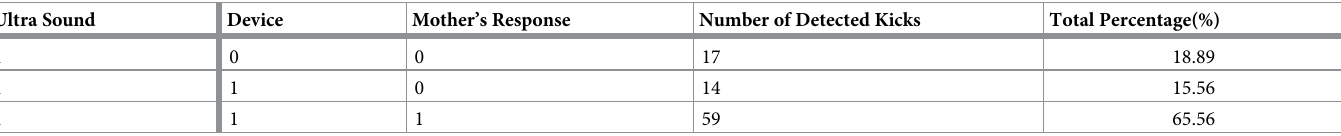
During the second phase of clinical testing three methods were utilized to identify the occurrence of a fetal movement. They are: the abdominal ultrasound, the in-house fabricated device and mother’s response. In the table ‘1’ indicates that the relevant method was able to identify the fetal movement and ‘0’ indicates that the method was not able to identify the fetal movement. For instance the first data row of the table indicated the number of realizations captured only by the abdominal ultrasound. The second row indicate the number of fetal movement captured by the ultra sound and the in-house fabricated device. And the final row indicate the fetal movements captured by all three